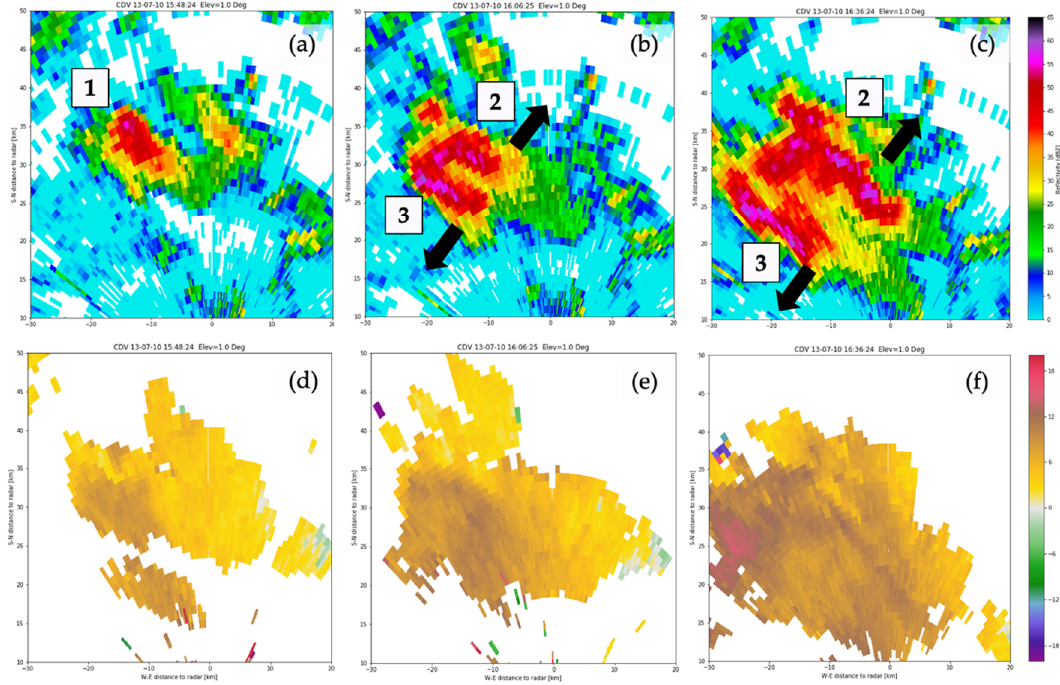
Figure 9. Raw CDV radar reflectivity and radial velocity for the splitting case on 10 July 2013 at 2 ◦ elevation angle. ( a – d ) 15:48:24 UTC (primary cell). ( b – e ) 16:06:25 UTC (during splitting). ( c – f ) 16:36:24 UTC (daughter cells after splitting). Numbers indicate the primary cell (1) and the two cells involved in the splitting process (2–LM and 3–RM). Black arrows indicate the propagation directions of cells 2 and 3 after the split.